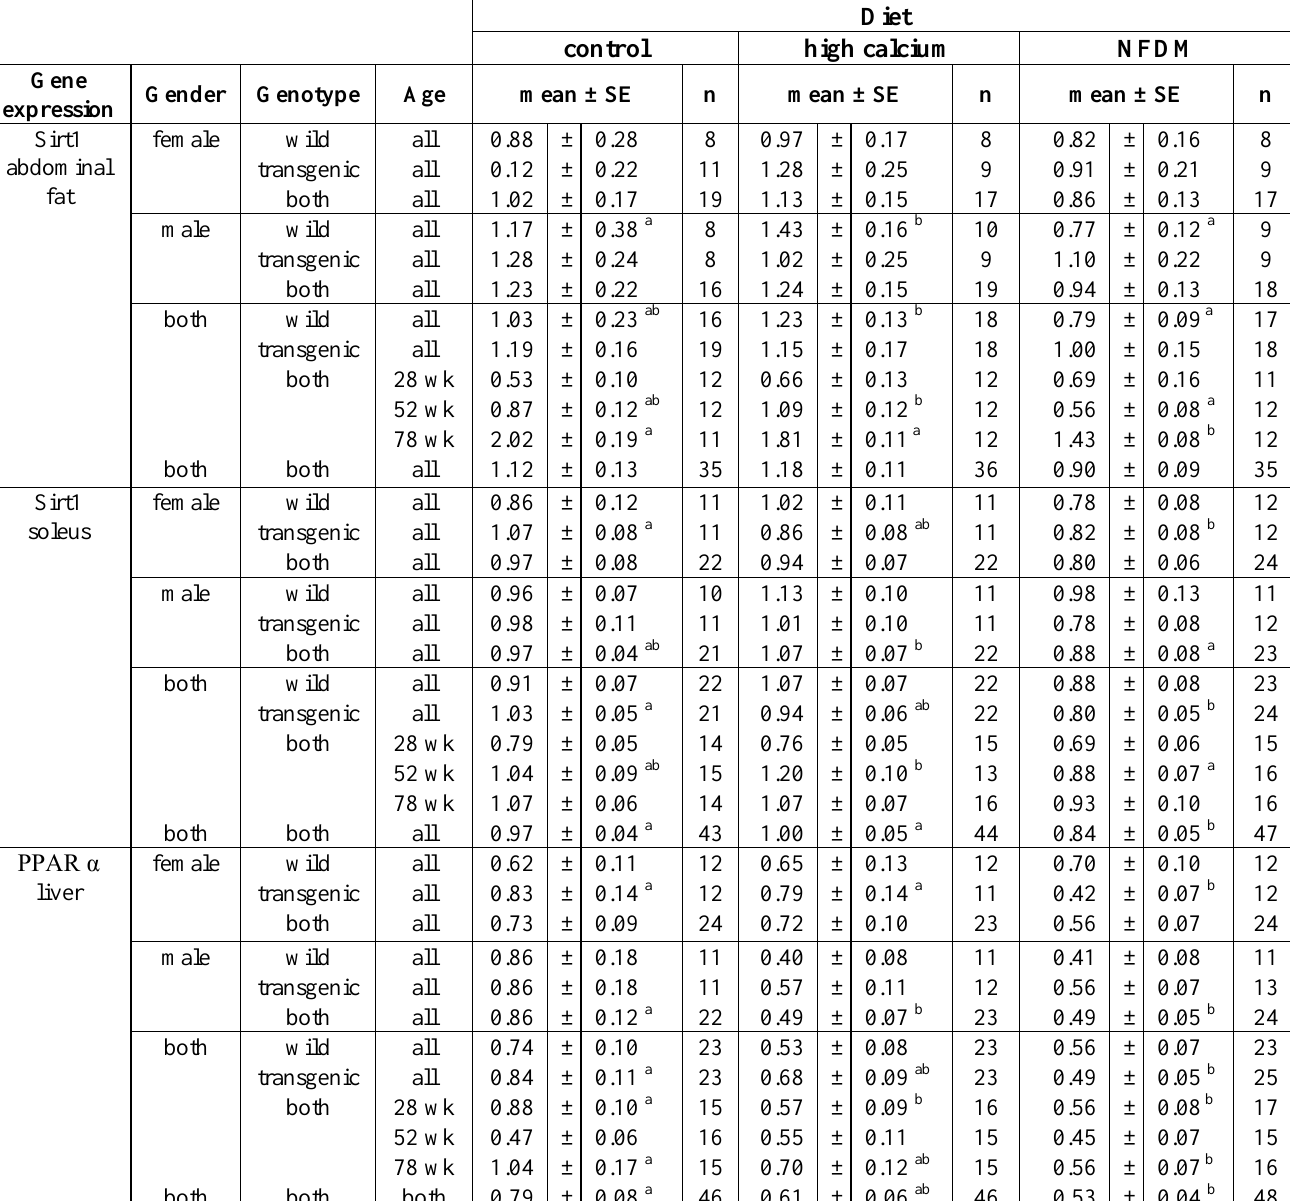
Table 6. Sirt1 (inguinal fat and soleus muscle) and PPARα (liver) gene expression in aP2-agouti transgenic and wild-type mice fed a control, high calcium or NFDM diet. Data are normalized to 18S expression. Values are expressed as mean ± SE. Non-matching superscripts denote significant differences between diet groups, p <